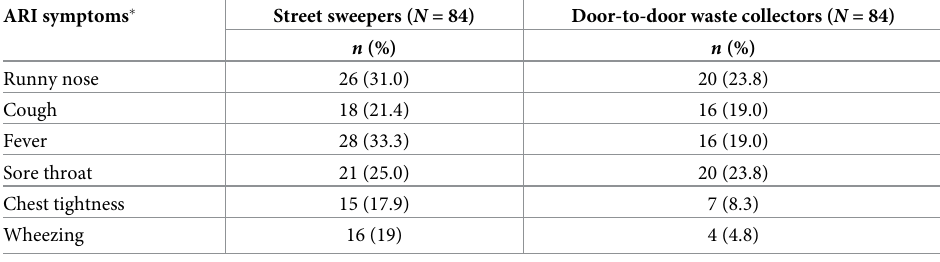
Table 5. Symptoms of ARI among street sweepers and door-to-door waste collectors in Dessie city, Ethiopia, March to May